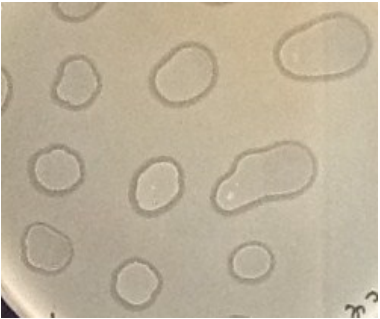
Figure 4. Test of phage 9g- E. coli C600 PAs (passage N° 15) for phage production on lawns of E. coli C600. 5 μL drops of the PA suspension in physiological saline were applied over lawns of E. coli C600. Lysis of the lawn around the drops indicates the presence of the active